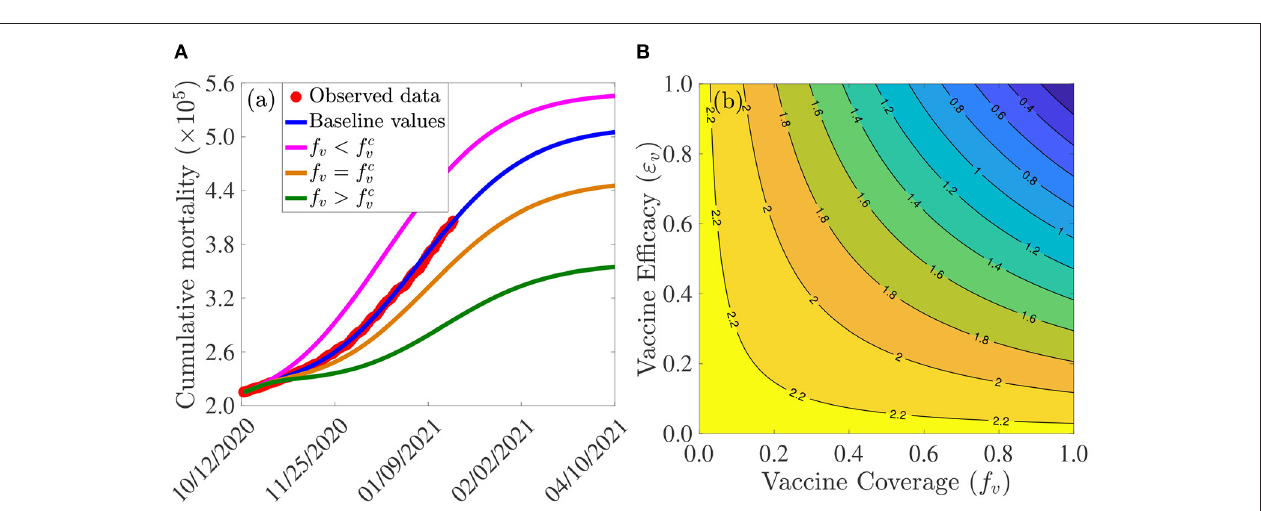
FIGURE 3 | Assessment of the effects of vaccine coverage ( f v ) and efficacy ( ε v ) on COVID-19 dynamics in the U.S. (A) Simulations of the model { (2.5),(2.6) } , with α 12 = α 21 = 0, showing the cumulative COVID-19 mortality in the U.S., as a function of time, for various values of vaccine coverage. Parameter values used are as given by the baseline values in Tables 3 , 4 , with α 12 = α 21 = 0 and various values of f v . Magenta curve ( f v = 0.3021 < 0.5900 = f c v ), blue curve (baseline parameter values, and baseline level of social-distancing compliance inherent in the cumulative mortality data, for the period October 12, 2020–January 20, 2021, used to fit the model), gold curve ( f v = 0.5900 = f c v ) and green curve ( f v = 0.9216 > 0.5900 = f c v ). The observed cumulative deaths data, fitted to the baseline scenario predicted by the model (blue curve), is shown in red dots. (B) Contour plot of the control reproduction number ( R c ) of the model { (2.5),(2.6) } , with α 12 = α 21 = 0, as a function of vaccine coverage ( f v ) and vaccine efficacy ( ε v ). Parameter values used are as given in Tables 3 , 4 , with α 12 = α 21 = 0. TABLE 5 | Vaccine-induced herd immunity threshold ( f c v ) for the U.S. for various levels of increases in baseline social-distancing compliance ( c s ). Herd threshold Herd threshold (%) Herd threshold (%) Herd threshold (%) Vaccine name (efficacy)